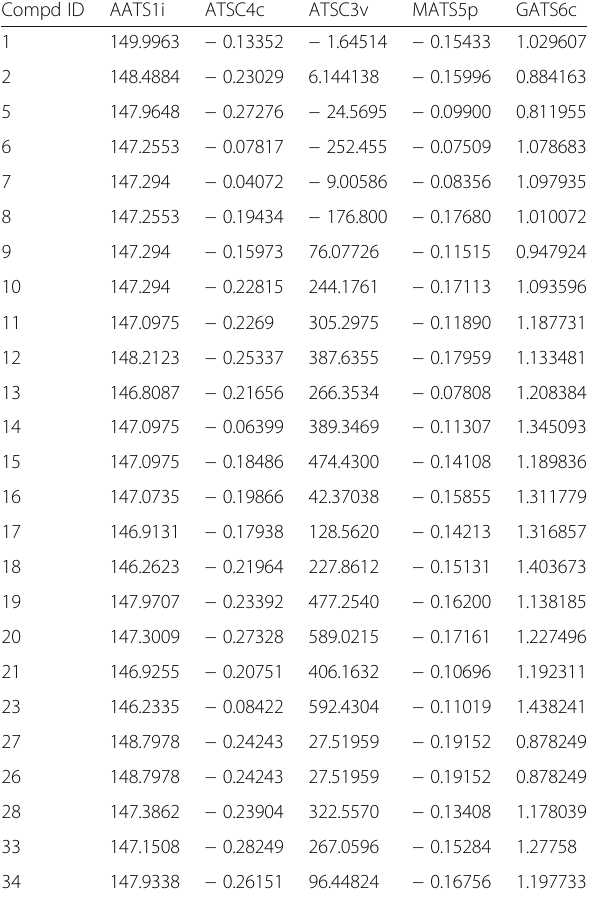
Table 4 Predicted descriptors score values for training set compounds (model 1)